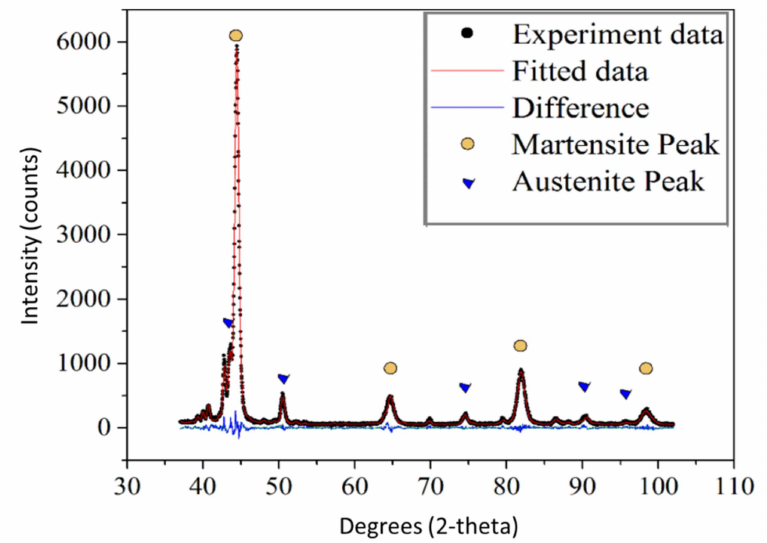
Figure A5. XRD di ff ractogram of AISI D2 tool steel austenitized at 1020 ◦ C in as-quenched condition. The fitted model (red line) obtained from TOPAS is in good acceptance (blue line) with the experimental data (black dots). Martensite and austenite are indexed in the